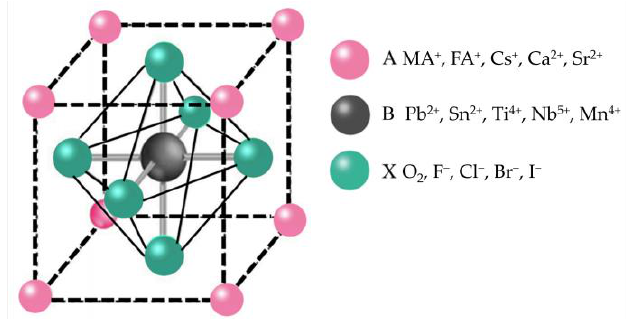
Figure 1. Typical crystalline structure of perovskite.